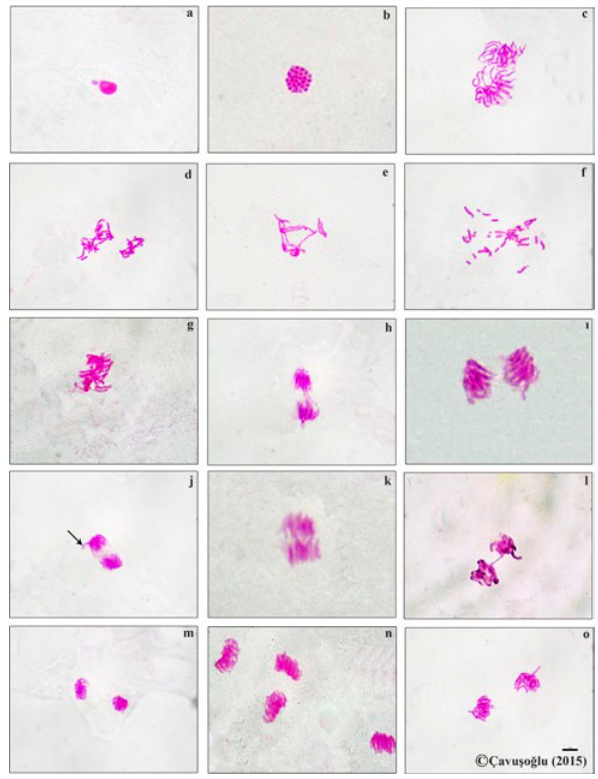
Fig. 2. Chromosomal aberrations in root meristems of barley seeds germinated in distilled water and different NaCl concentra- tions after treatment with 28 mg/L humic acid: a) micronucleus; b) granulation c) disorderly prophase; d) disrupted equatorial plate; e) uncoiling chromosomes f) fragments g) sticky chromosomes; h) bridges in anaphase and lagging chromosome; ı) fault polarization in anaphase; j) vagrant chromosome in anaphase (arrow); k) align- ment anaphase; l) bridges in telophase; m) fault polarization in telo- phase n) distant poles in telophase; o) vagrant chromosome in telo- phase. Scale bar = 10